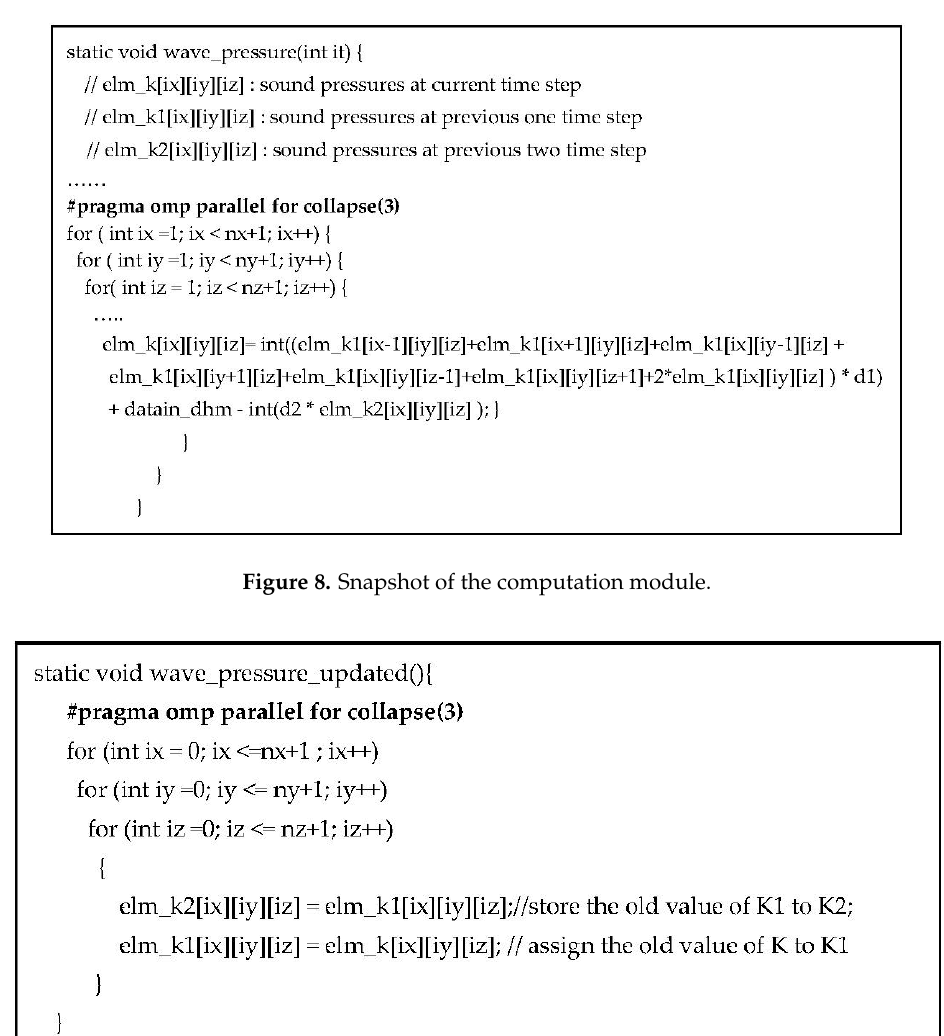
Figure 7. Computation flow of the software simulation.